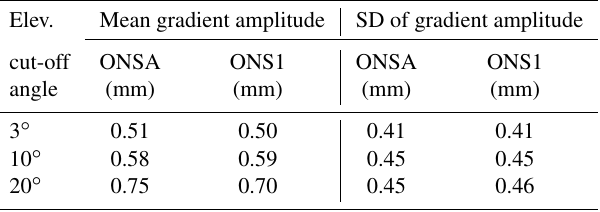
Table 10. The impact of the elevation cut-off angle on the estimated 15min GPS gradient amplitude ∗ .